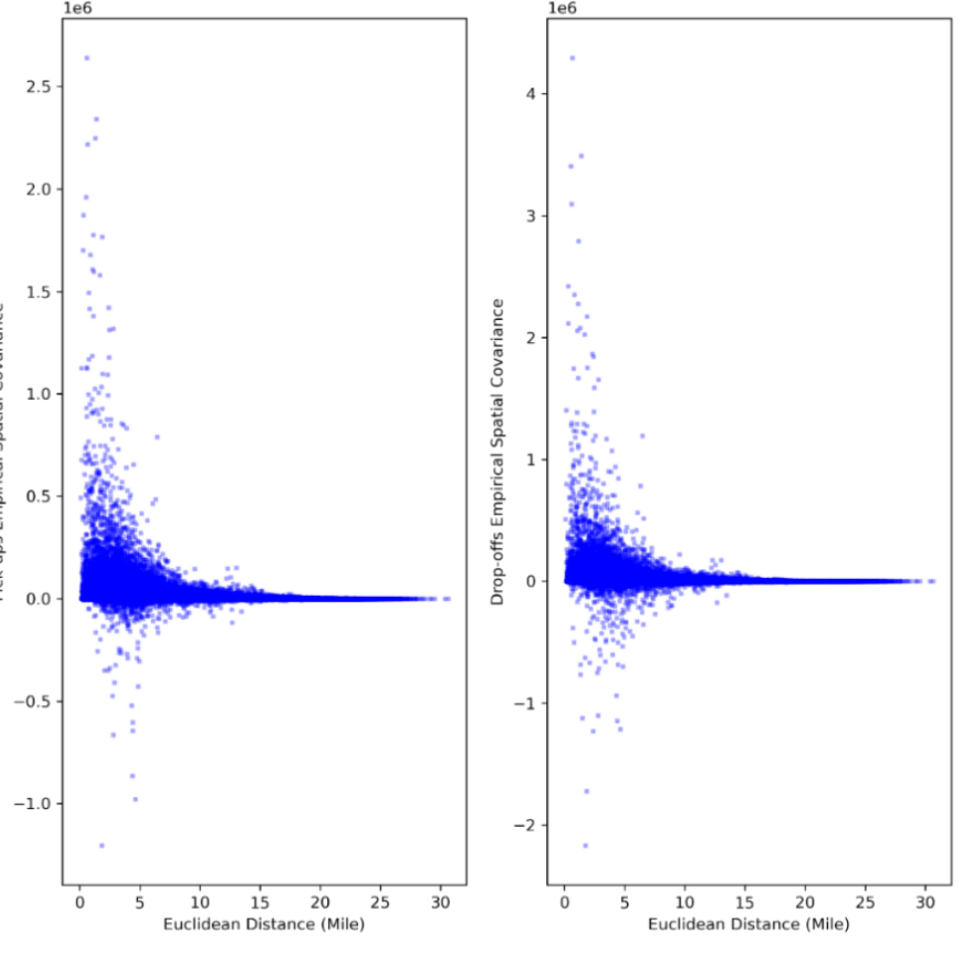
Figure 4: TNC Demand Empirical Spatial Covariance and Euclidean